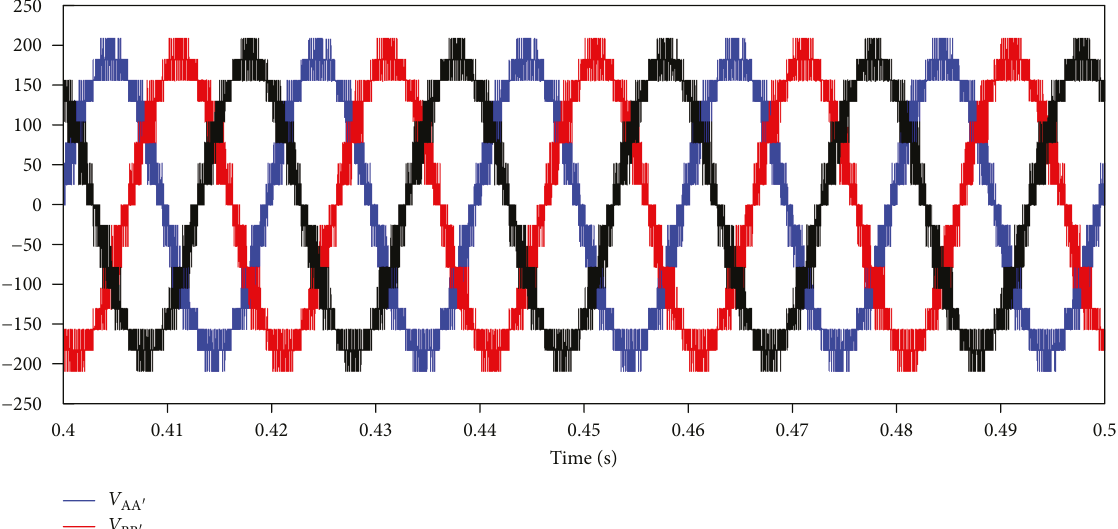
Figure 17: Three-phase output voltage of the HMC.